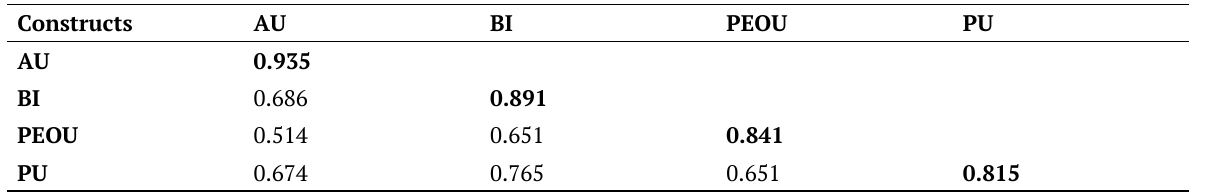
Table 3. Fornell-Larcker